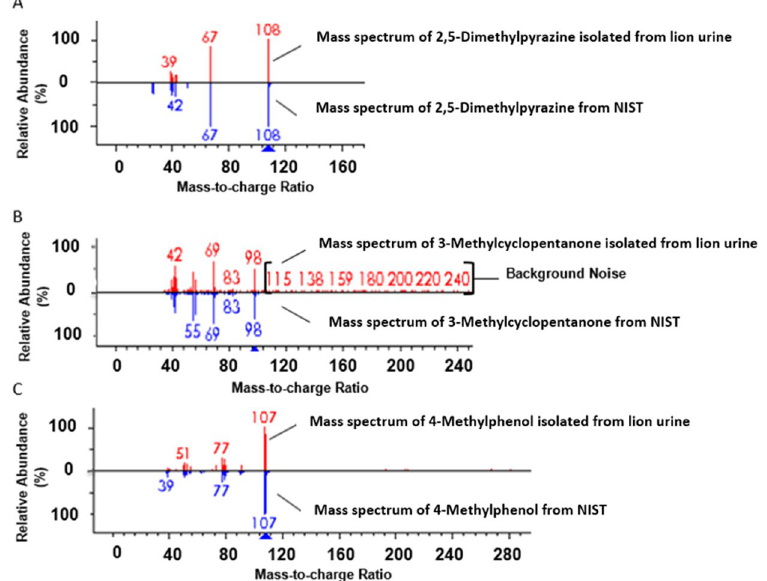
Figure 6. Confirmation of characteristic odorous compounds of lion marking fluid. Mass spectral confirmation of the three compounds responsible for the characteristic odor of lion marking fluid in a Selective Heart-Cut- Cryo mode using the NIST mass spectral library. The relative abundance gives the proportion of ions detected of different masses relative to the largest ion